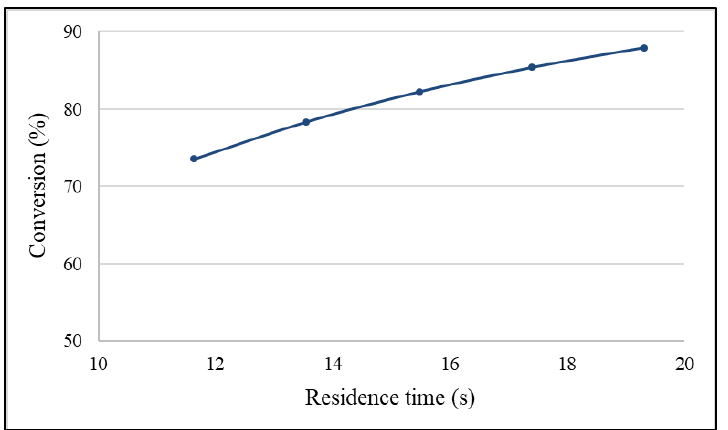
Figure 3. Effect of residence time on the conversion of 4-propylguaiacol. Reaction conditions: Temperature, 400 ◦ C; pressure, 300 psig; gas phase, hydrogen; liquid phase, 4-propylguaiacol; liquid flow rate, 0.03 mL ∙ min −1 ; gas flow rate, 0.09 mL ∙ min −1 .